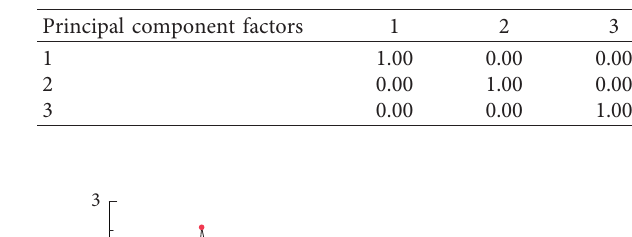
Table 2: Principal component load matrix. Table 3: The covariance matrix of the principal component factors.